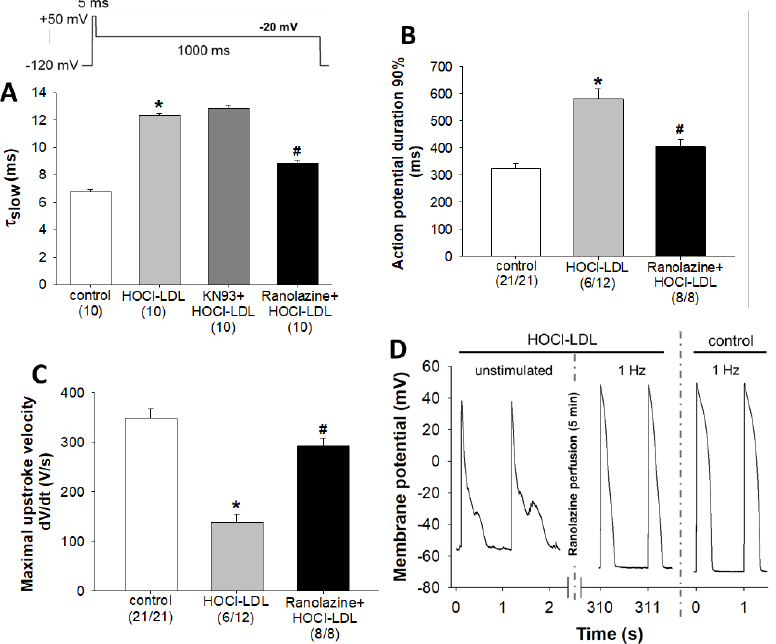
Figure 5. oxCaMKII-independent activation of I NaL by HOCl-LDL. ( A ) Time constant of the slow inactivation phase (τ slow ) of I Na as a measure of I NaL in GPV cardiomyocytes incubated with HOCl-LDL (oxidant:lipoprotein molar ratio of 200:1, 250 µg/mL, 12 – 16 h) with or without KN93 (5 µM) or ranolazine (10 µM) added 30 min prior to HOCl-LDL (the voltage clamp protocol is illustrated in the inset). ( B ) APD at 90% repolarization and ( C ) maximal upstroke velocity of GPV cardiomyocytes treated with HOCl-LDL (oxidant:lipoprotein molar ratio of 400:1, 250 µg/mL, 12 – 16 h, 1 Hz stimulation frequency) with or without ranolazine (10 µM, added 30 min prior to HOCl-LDL). ( D ) Representative AP recordings from a HOCl-LDL (oxidant:lipoprotein molar ratio of 400:1, 250 µg/mL, 12 h)-incubated GPV cardiomyocyte before (0 – 2 s, unstimulated) and after (310 – 311 s, stimulated at 1 Hz frequency) superfusion with ranolazine (10 µM, 5 min). For comparative purposes, representative APs of a control cardiomyocyte (0 – 1 s, stimulated at 1 Hz frequency) are shown. Values are expressed as mean ± SEM. ( n ) represents the number of cardiomyocytes and (n/n) represents the number of myocytes showing stimulated APs / total number of patched myocytes. Cardiomyocytes showing arrhythmic events were excluded from the analysis. * indicates p < 0.05 vs. control, # indicates p < 0.05 vs. HOCl-LDL.